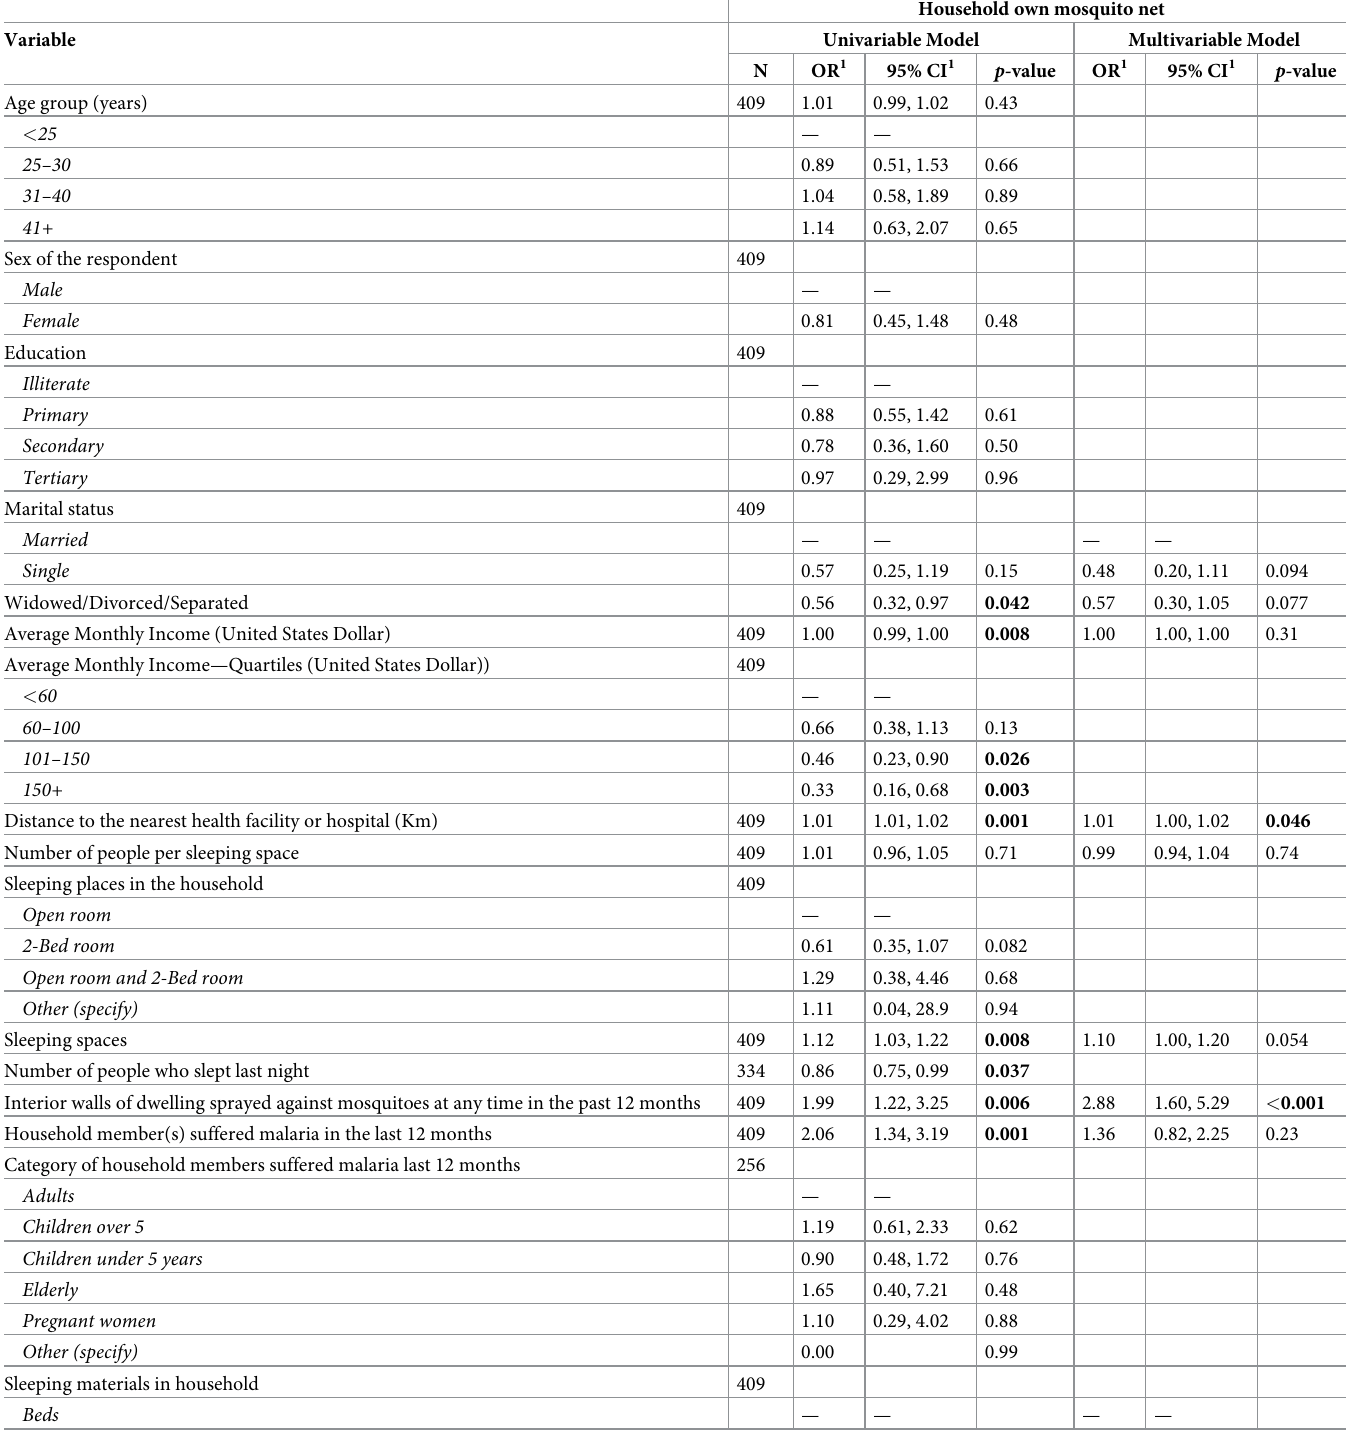
Table 3. Logistic regression model results of factors associated with net